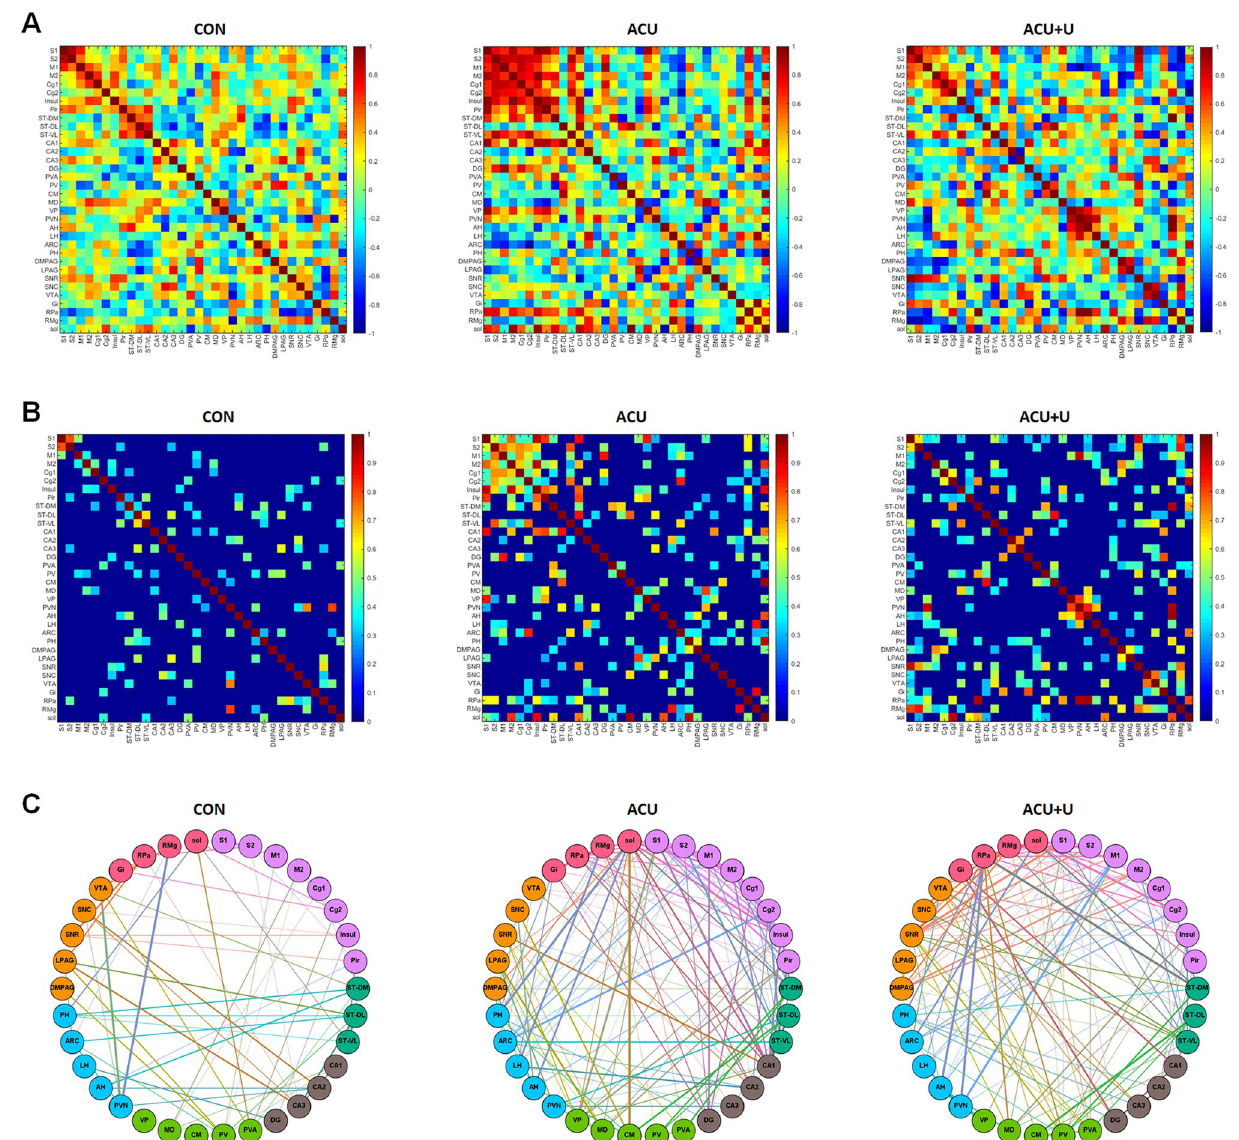
34 brain regions. ( B ) The threshold square of inter-regional correlations for c-Fos activation. Acupuncture produces a high correlation between the brain regions of the cortex, and these correlations were mostly altered by U0126 administration. Red colour indicates high correlation and blue indicates low-correlation (scale, right). ( C ) A circular layout grouped by major brain subdivision to show the connectivity between the brain regions. Nodes are connected by the edges of super-threshold inter-regional correlations. CON control; ACU acupuncture treatment, ACU + U U0126 administration followed by acupuncture treatment. Abbreviations for each brain region are shown in Table